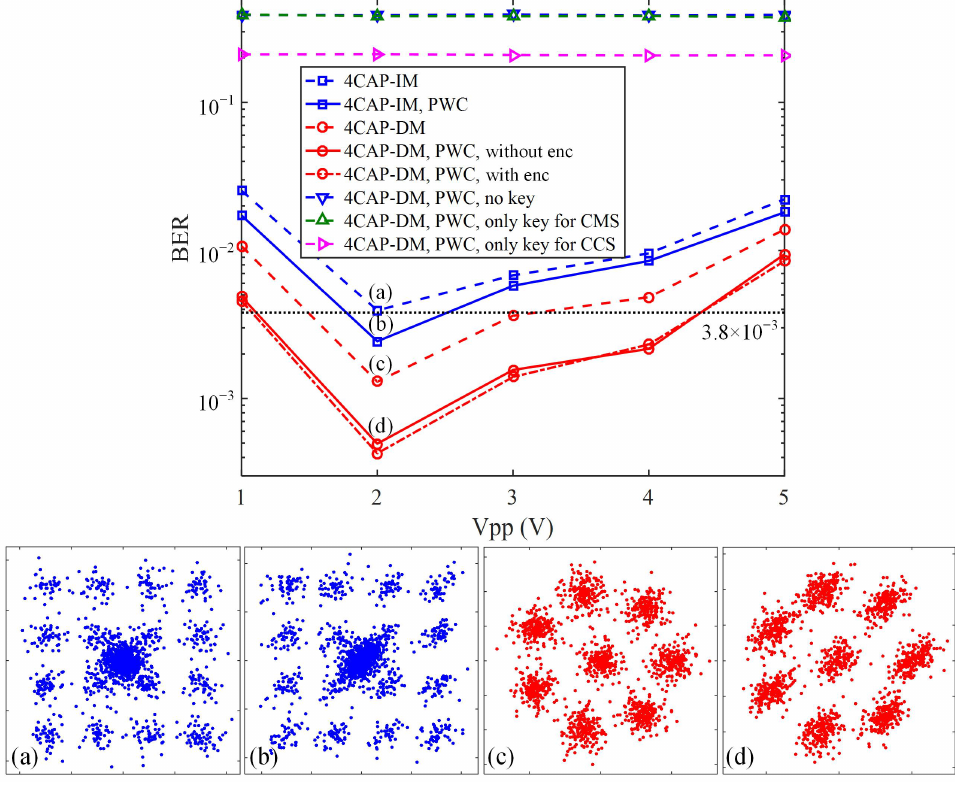
Figure 6. Measured BER vs. Vpp for different cases. Insets ( a – d ): the corresponding received constellation diagrams.